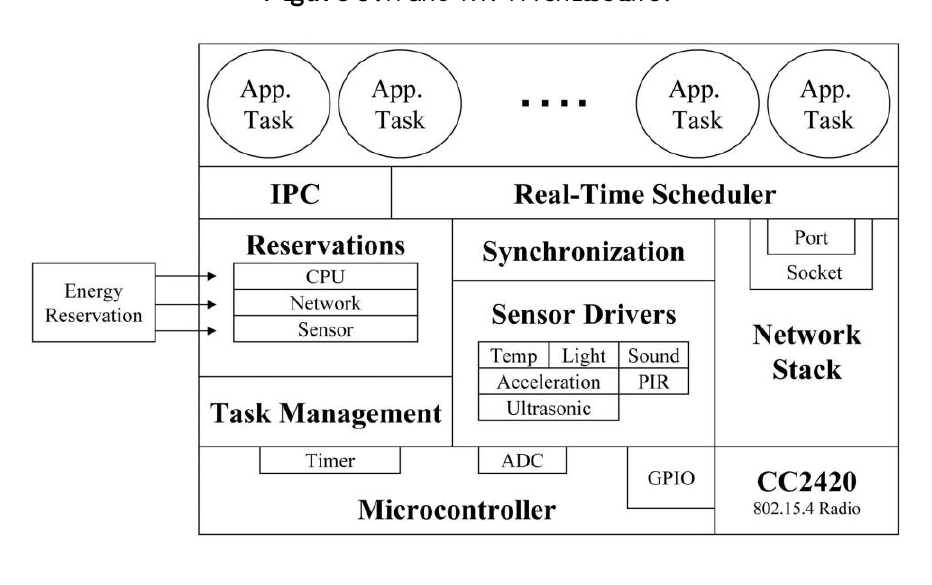
Figure 5. Nano-RK